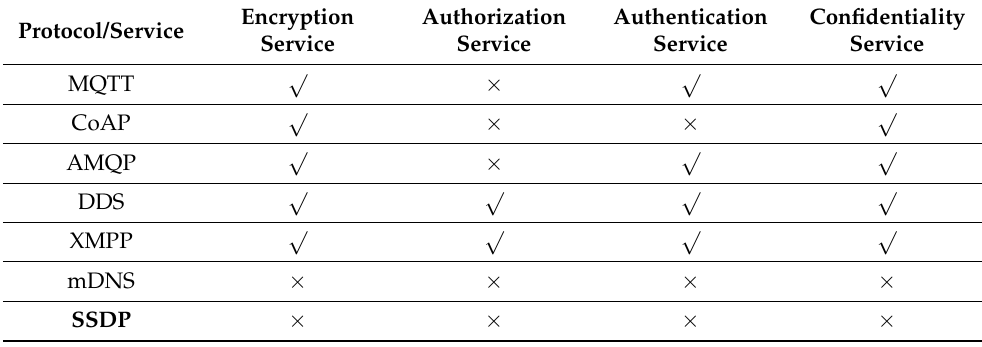
Table 2. Classification of security services provided by IoT protocols for mitigating attacks.